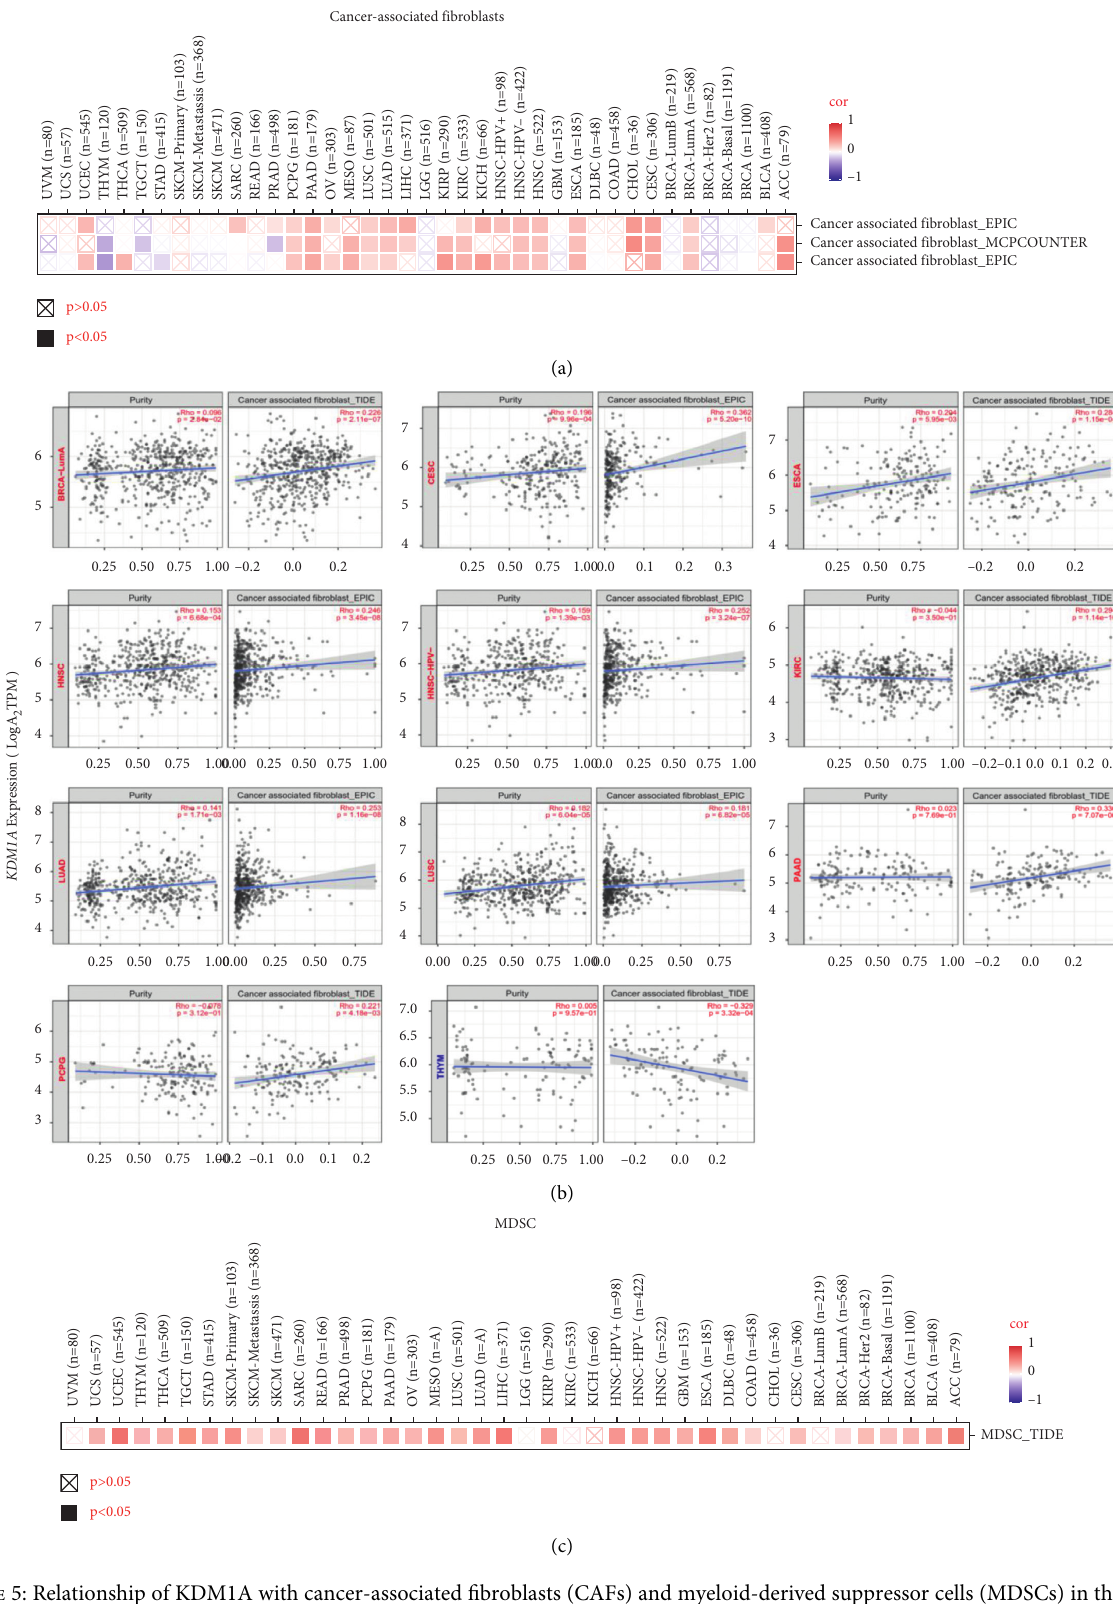
Figure 5: Relationship of KDM1A with cancer-associated fibroblasts (CAFs) and myeloid-derived suppressor cells (MDSCs) in the tumor microenvironment. (a) The scores of CAF were associated with the expression of KDM1A gene via EPIC, MCPCOUNTER, and TIDE algorithms. (b) Correlation between KDM1A expression and infiltration level of CAFs. (c) TIDE algorithm showed MDSCs were positively correlated with KDM1A in most cancer